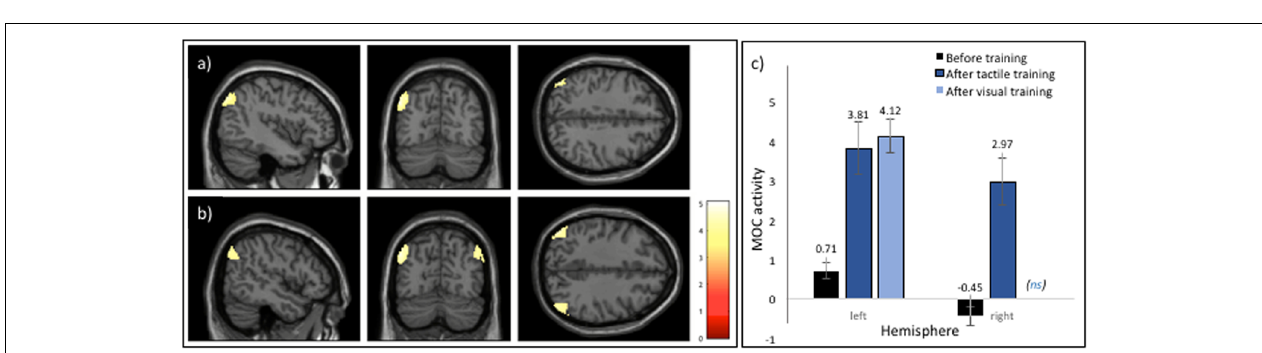
FIGURE 4 | Regions demonstrating a significant increase in activation during the categorisation task post training. (A) A main effect of training was associated with increased activation in the left MOC. (B) An illustration of the result of subsequent analyses of the effect of training modality which revealed bilateral activation in the MOC following training using touch. (C) Barplot showing relative increases in both the left and right MOC during the visual categorisation task from before to after training, with after-training activity shown dependent on the training modality of vision or touch. Note that barplots depicting the mean peak activations post-training are shown only for regions associated with a significant increase in activation (i.e., activation in the right MOC to visual training was not significant, ns). See text for details on the cluster-based analyses conducted. Error bars represent ± 1